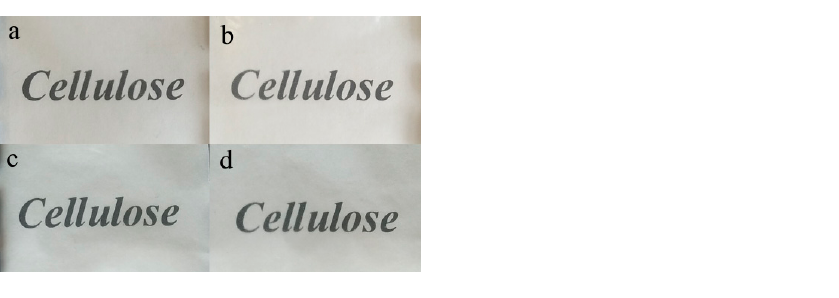
Figure 4. Photograph of specimens prepared by EM: ( a ) RWSC; ( b ) 0.1% CNF; ( c ) 1.5% CNFs; ( d ) 3.0% CNFs. ( d ) 3.0%